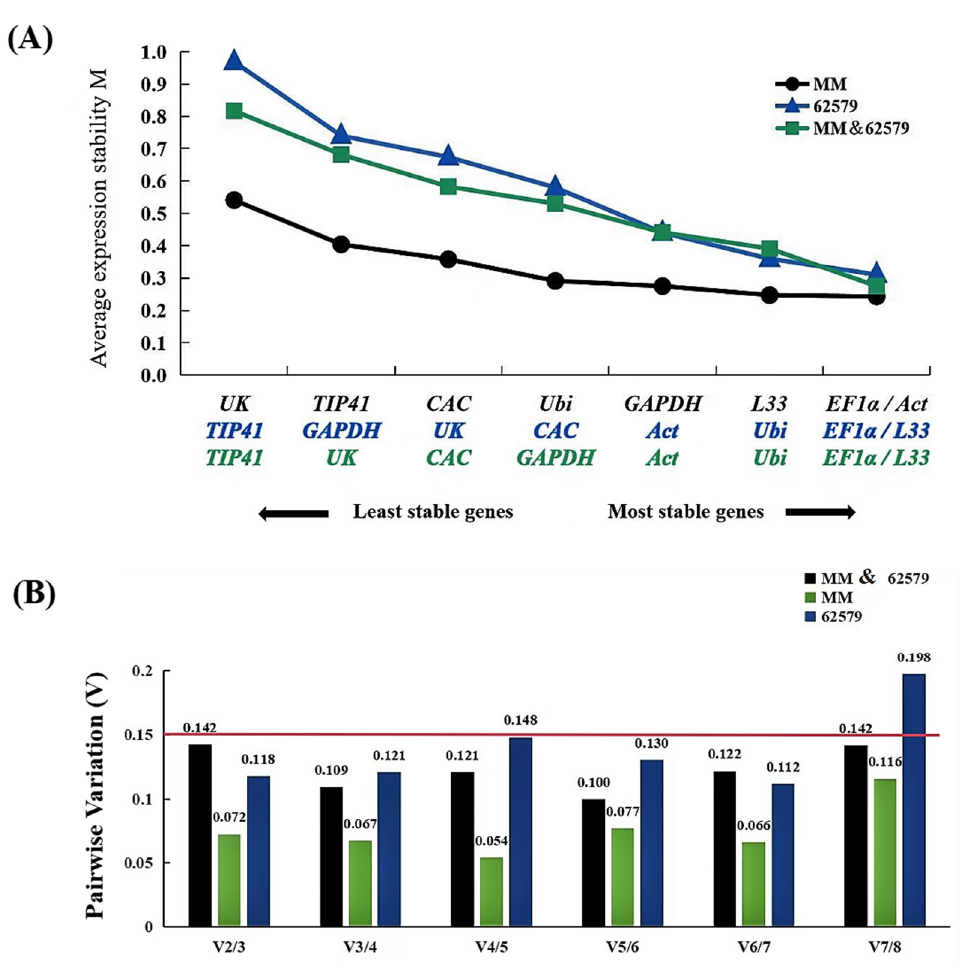
Figure 3. Analysis results of geNorm Software. ( A ) Expression stability of eight reference genes analyzed by geNorm. ( B ) geNorm analysis of eight reference genes matching variation values. The red line is a 0.15 threshold line.